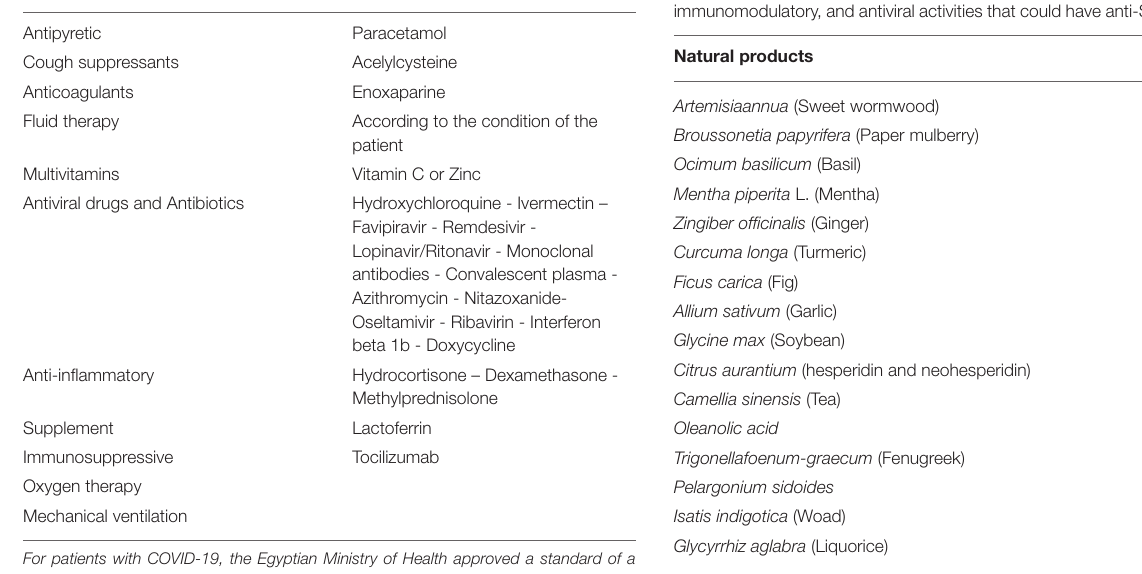
TABLE 5 | Egyptian protocol for COVID-19 treatment/management. TABLE 6 | Summary of some functional food plants of anti-inflammatory,